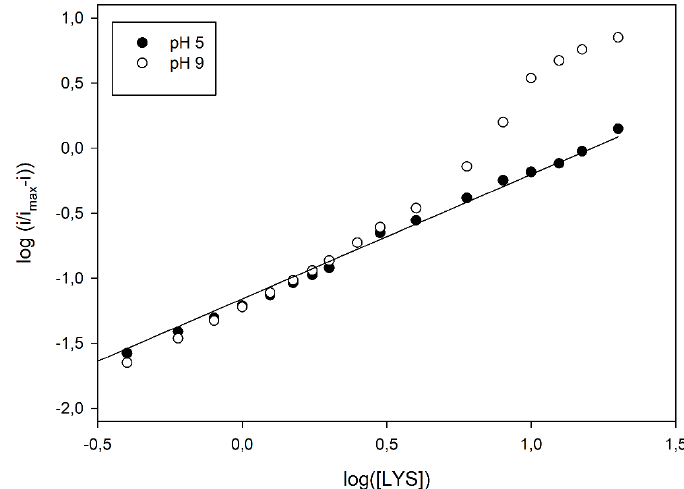
Figure 4. Hill plot of normalised current responses vs. L-lysine concentration as shown in Figure 3. Straight line refers to linear fitting of data points at pH 5 (•).